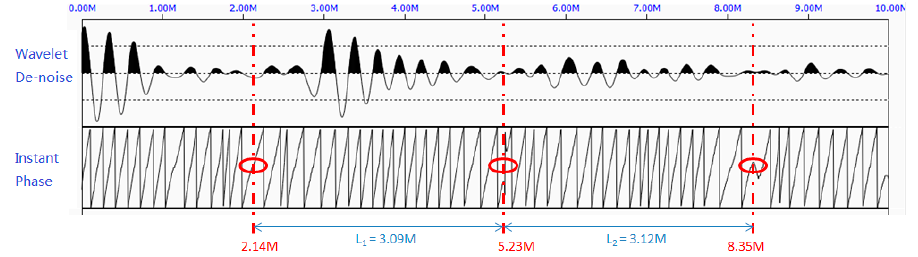
Figure 16. The denoised waveform by wavelet denoising algorithm ( top ) and the periodic pattern of the instant phase ( bottom ) at Site 2.